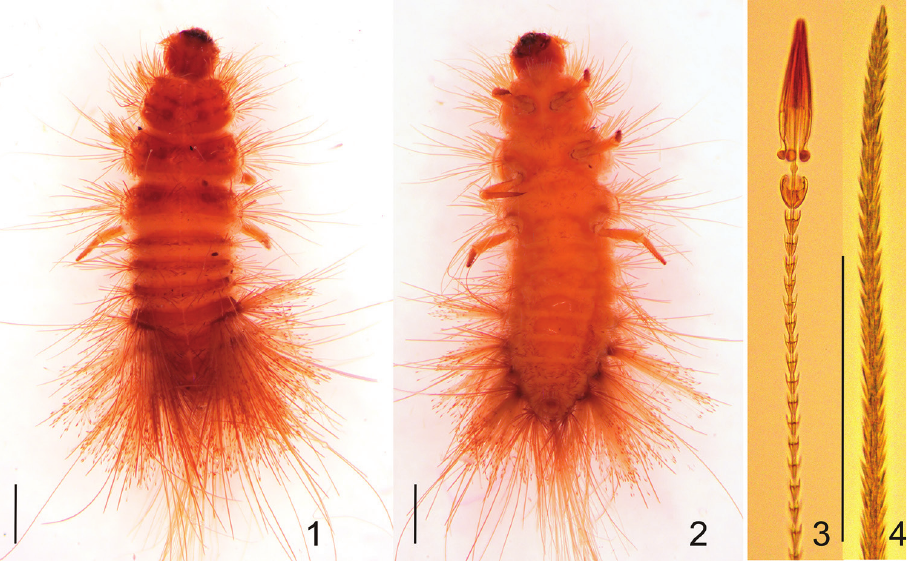
Figures 1–4. Mature larva of Ctesias (s. str.) serra (Fabricius, 1792). 1 Dorsal view 2 Ventral view 3 Head (apex) of hastiseta 4 Spiciseta. Scale bars: 0.1